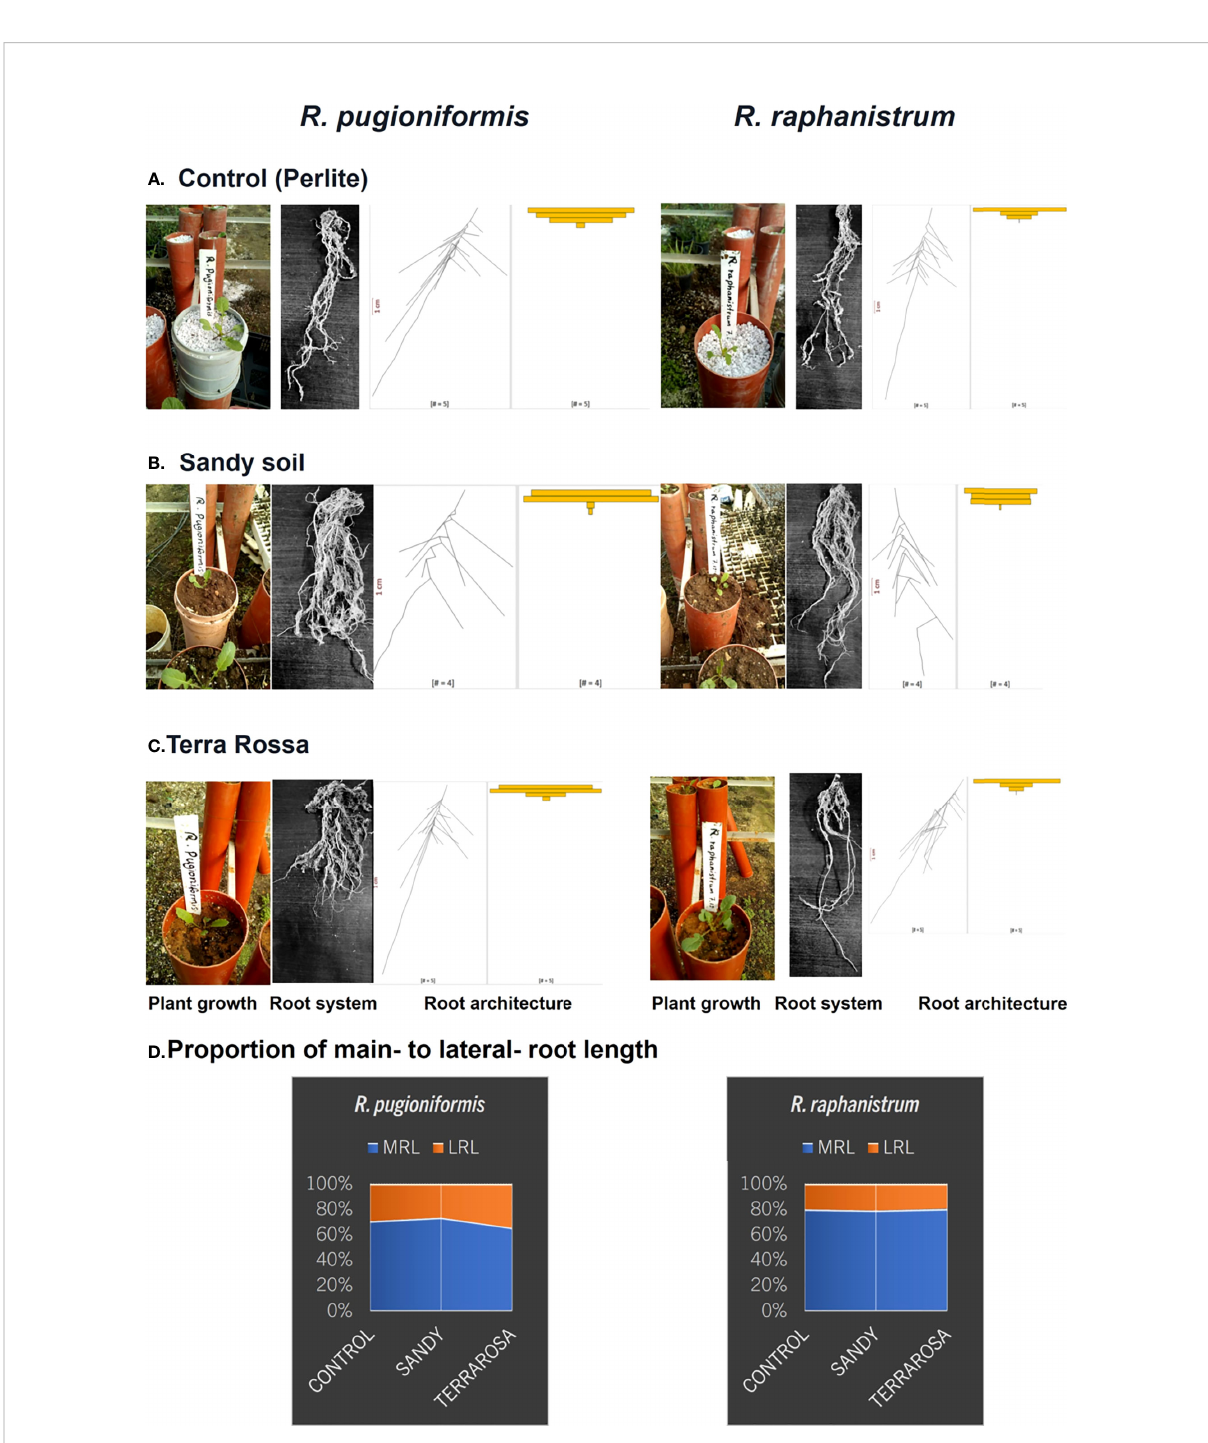
FIGURE 2 Characteristic difference between main and lateral root lengths of R. pugioniformis and R. raphanistrum growing on native and non-native soils. R. pugioniformis requires signi fi cant modulation of main- to lateral-root length proportion on different soils (A – C) , while the general root architecture of R. raphanistrum remained unaffected (D) . The two species were potted in three different soils, control (A) , Hamra, native soil of Rr (B) , and Terra Rossa, native soil of Rp (C) . The plants were excavated at the start of bolting (78 days after germination), roots were rinsed from substrate, disentangled, photographed, and analysed via EZ-Rhizo II (see methods section for details). Next to the representative photographs of rinsed, disentangled root system, digitized root characters are presented as alpha blends, and the spread of Lateral Root Length (LRL) computed by Root-VIS II. The proportion of main- to lateral- root length (D) in all three soils were calculated from the digitized root